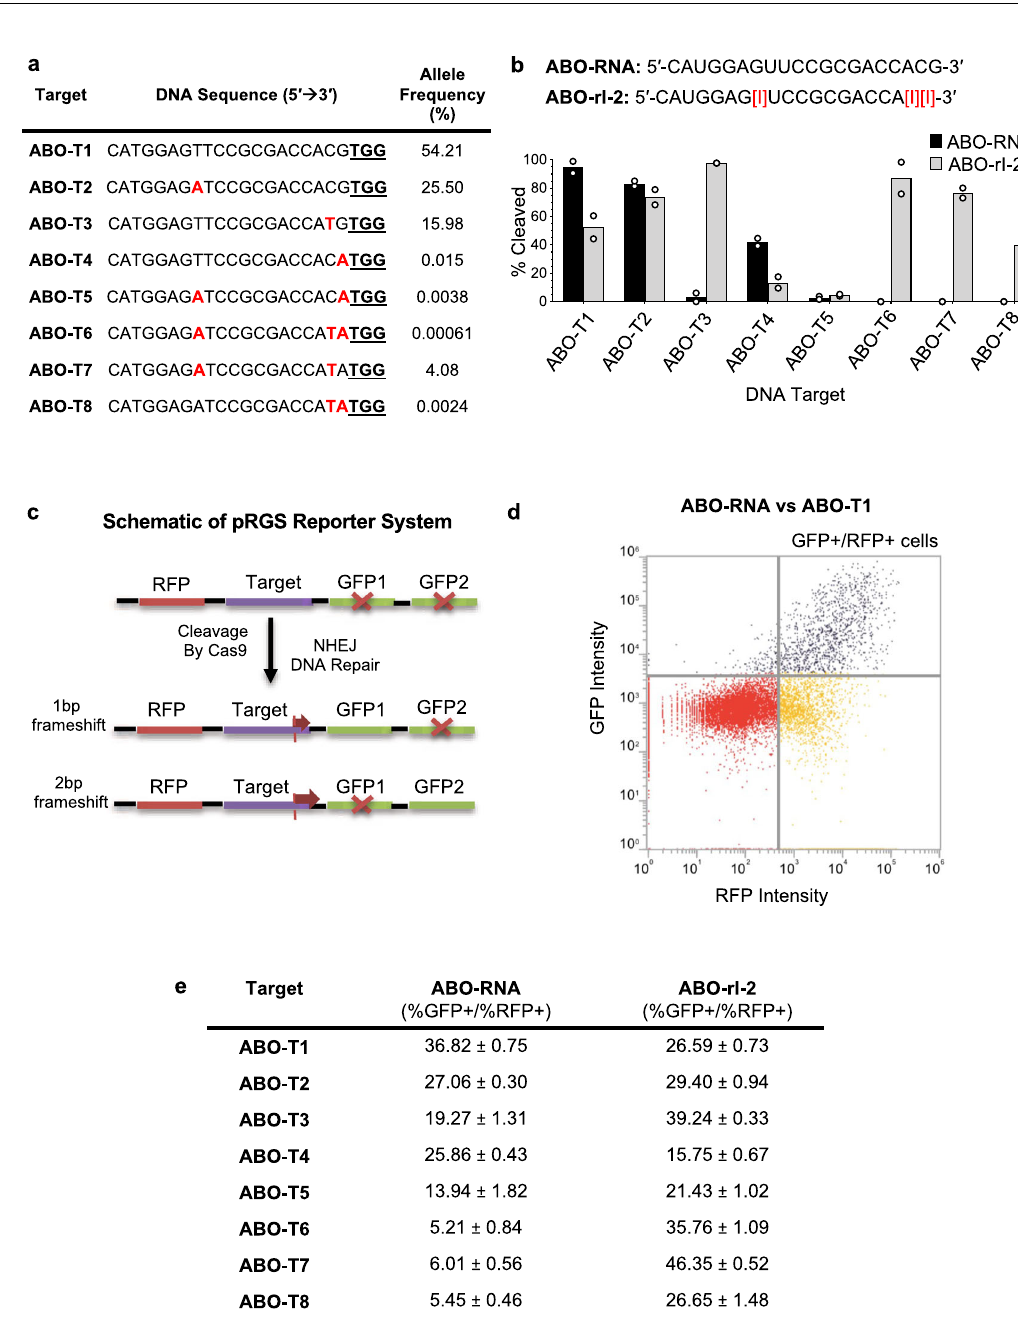
Fig. 3 crRNAs containing inosine bases direct simultaneous cleavage of polymorphic gene variants in cells. a List of ABO variant DNA target sequences (ABO-T1-T8) assayed in cells. Positions of SNPs are indicated with red lettering. The PAM sequence is underlined. b Bar graphs showing the relative amount of DNA cleavage resulting from in vitro reactions containing Cas9 with ABO-RNA or ABO-rI-2 versus the indicated DNA target sequences. Assays were performed using fi xed concentrations of gRNA (80 nM) and Cas9 (40 nM); Mean with individual data points shown ( n = 2 independent experiments). c Schematic outlining the framework for the fl uorescence-based assay used to evaluate cleavage of the ABO variant target sequences in cells. d Representative FACS plot showing the distribution of RFP and GFP positive cells. Dual positive cells appear in the top right quadrant. e Table showing normalized %GFP + /all %RFP + events corresponding to cleavage of the indicated target sequences in cells by Cas9 using either ABO-RNA or ABO-rI-2; Mean± S.D. shown ( n = 3 independent